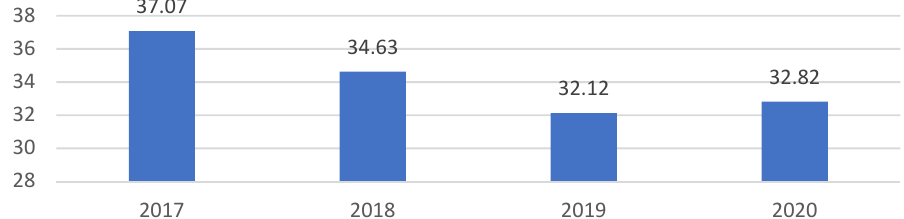
Figure 7. TAT (median) of biogas plants in 2017–2020 (%). Note: our calculations based on the biogas plant’s financial statements.